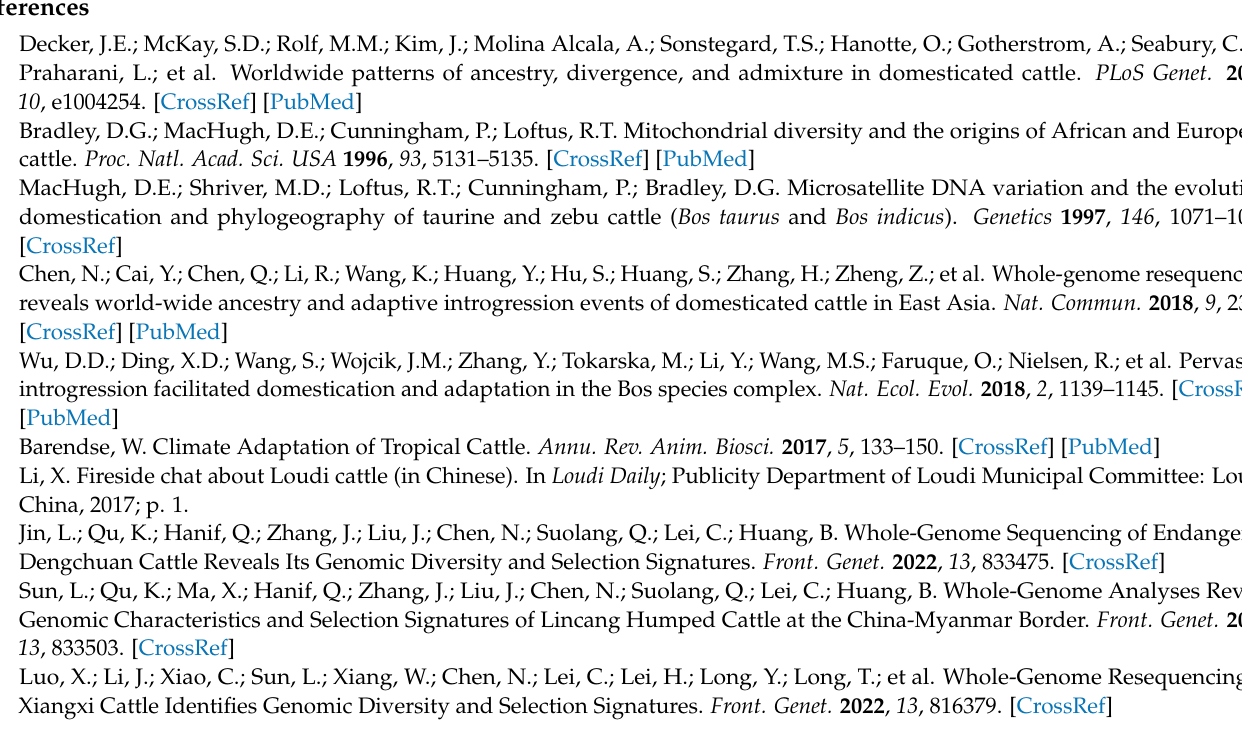
Table S7: A summary of genes from CLR in Loudi cattle; Table S8: A summary of genes from F ST in Loudi cattle (compared to Xiangxi); Table S9: A summary of genes from XP-EHH in Loudi cattle (compared to Xiangxi); Table S10: GO enrichment of Loudi cattle candidate genes; Table S11: KEGG pathway analysis of Loudi cattle candidate